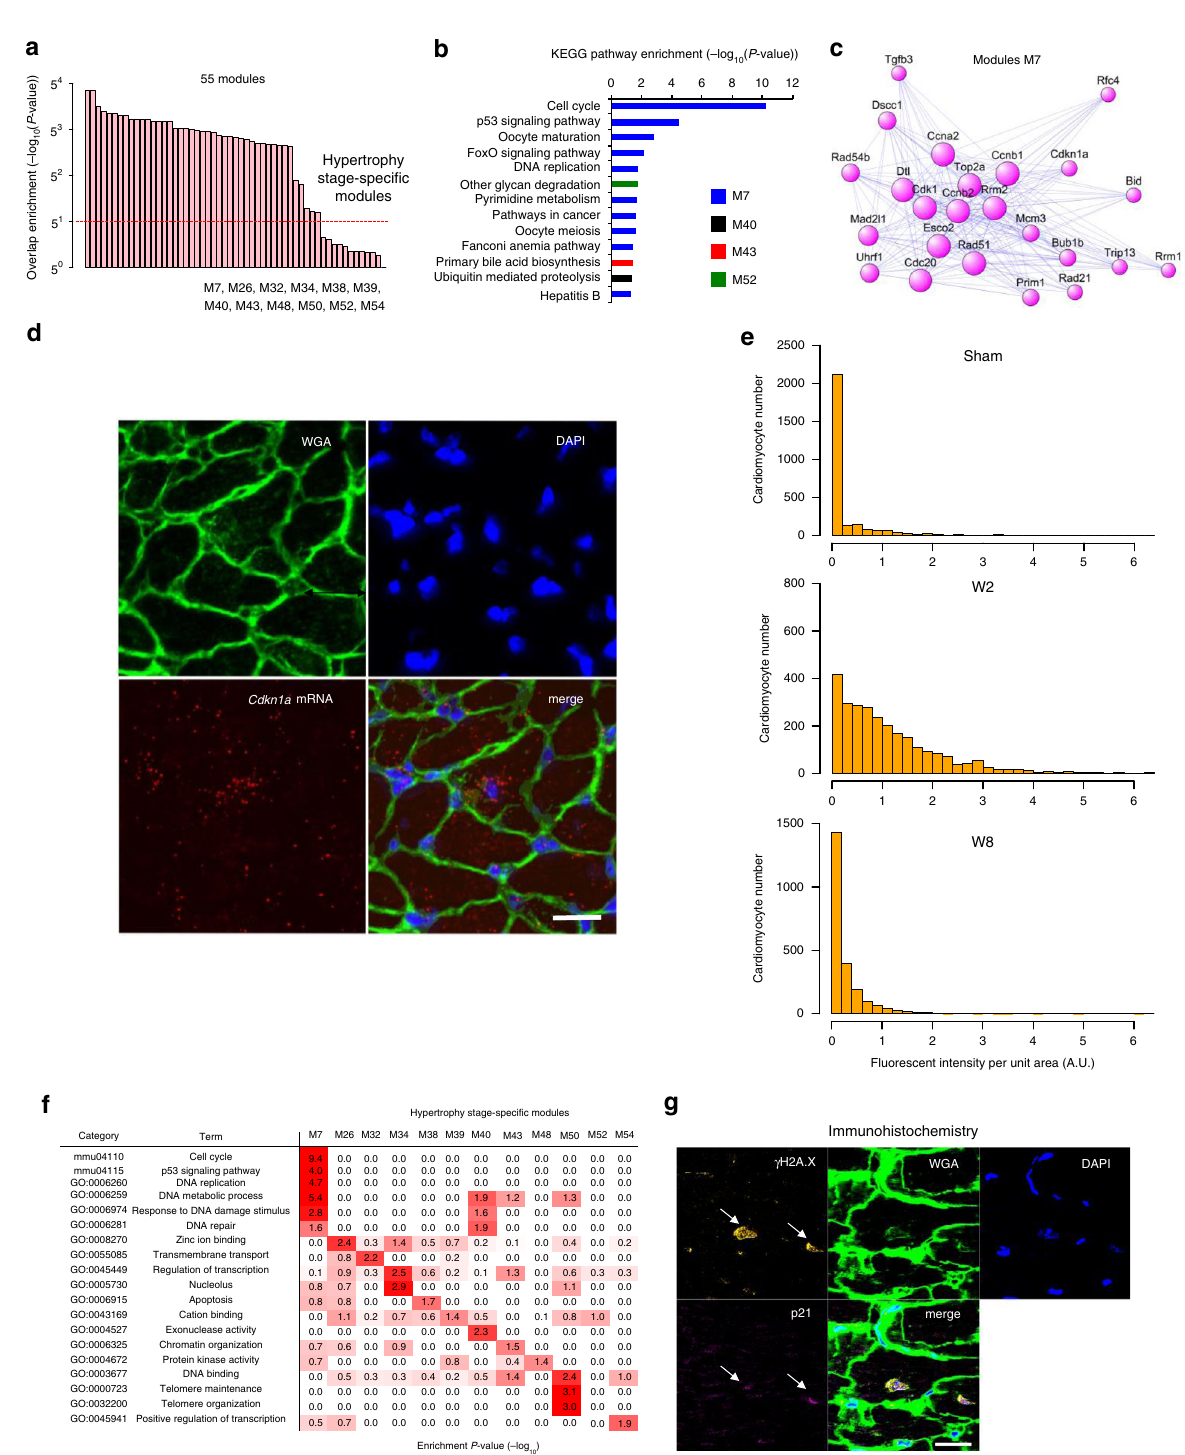
Fig. 4 Hypertrophy-stage-speci fi c p53 signaling activation. a Bar plot showing the statistical signi fi cance of the overlap between modules detected from co- expression analysis with or without hypertrophy-stage cardiomyocytes. The most strongly overlapping module pairs are selected from Supplementary Fig. 13a. Modules are ordered by signi fi cance level. The red line indicates the threshold for hypertrophy stage-speci fi c modules. b KEGG pathway enrichment of 12 hypertrophy stage-speci fi c modules identi fi ed in a and Supplementary Fig. 13a. c Co-expression network analysis of M7. d Representative images of Cdkn1a mRNA smFISH in the heart from mice at 2 weeks after pressure overload. Wheat germ agglutinin (WGA) and DAPI are used as markers of the plasma membrane and nucleus, respectively. Scale bar, 20 μ m. e Bar plots showing the distribution of cells corresponding to the single-cell fl uorescent intensity of Cdkn1a mRNA detected by smFISH in the heart after sham and TAC (weeks 2 and 8) operation. f Heatmap showing the enrichment of GO and KEGG pathway terms in 12 hypertrophy stage-speci fi c modules. g Immunohistochemical staining of gH2A.X and p21 in the heart of mice at 2 weeks after pressure overload. WGA and DAPI are used as markers of the plasma membrane and nucleus, respectively. Arrows indicate the nuclei of gH2A.X and p21 double-positive cardiomyocytes. Scale bar, 20 μ